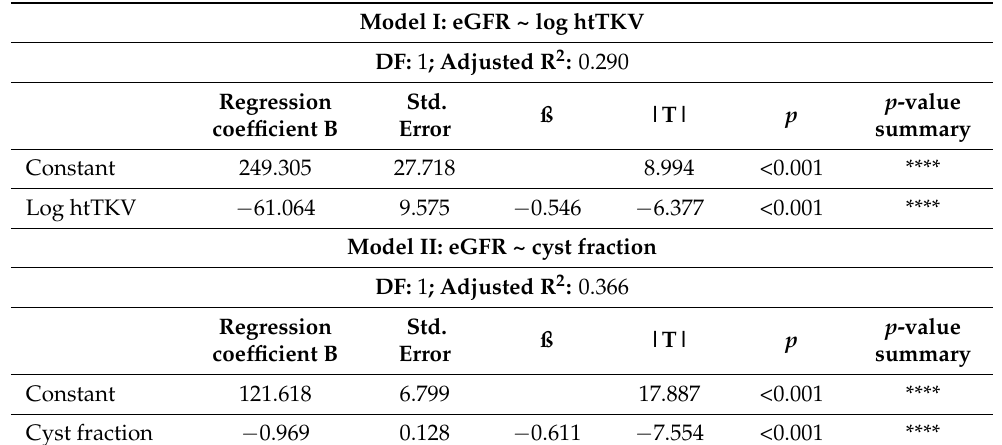
Figure 4. Correlation of cyst fraction with patients age (( A ) year 1: ρ = 0.531, p < 0.001; year 2: ρ = 0.502, p < 0.001) log htTKV (( B ) year 1: ρ = 0.881, p < 0.001 year 2: ρ = 0.832, p ≤ 0.001) and eGFR (( C ) year 1: ρ = − 0.573, p < 0.001, year 2: ρ = − 0.560, p < 0.001) of the longitudinal cohort. Spearman correlation was performed for non-parametric data. eGFR, estimated glomerular filtration rate; htTKV, height adjusted total kidney volume.